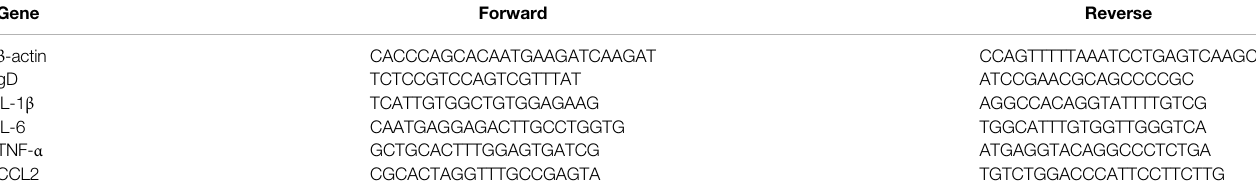
TABLE 3 | The primers used in this study.